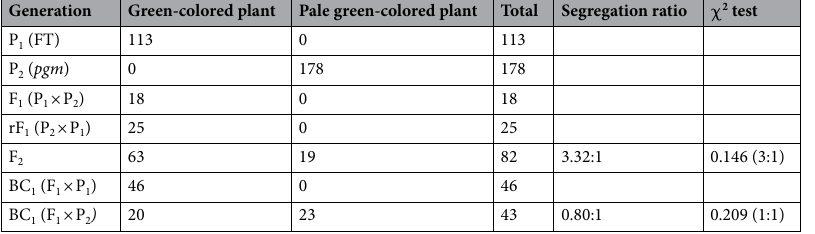
Table 3. Genetic analysis of pgm in Chinese cabbage.